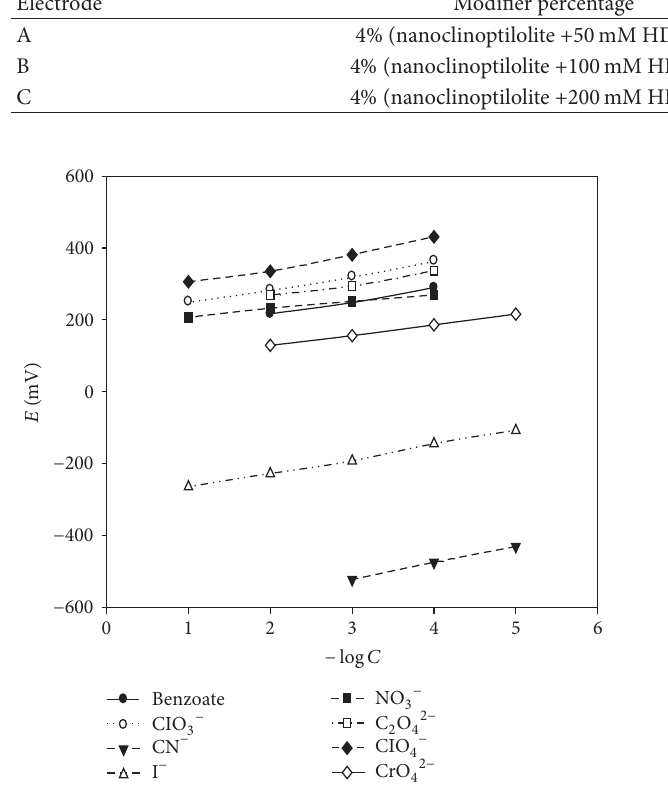
F 4: A schematic diagram of the electrode response to various anions.